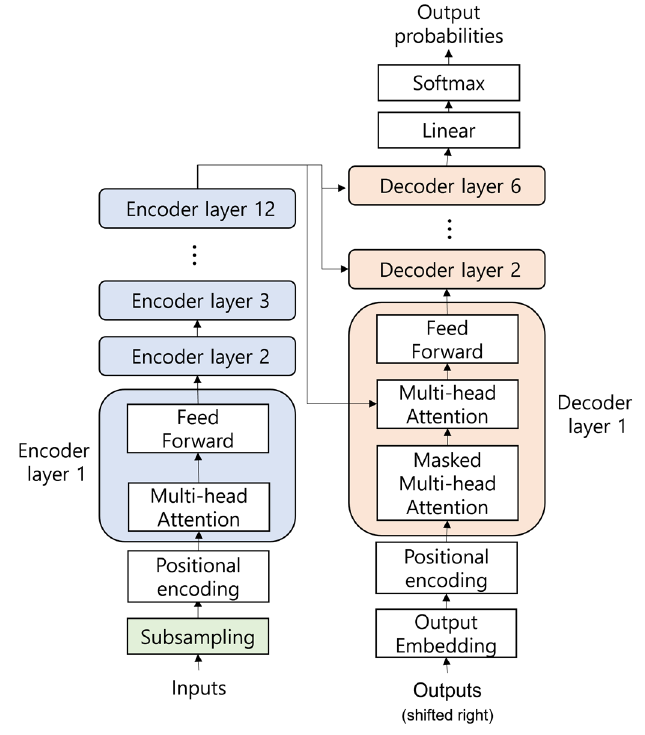
Figure 1. Baseline encoder-decoder network architecture.